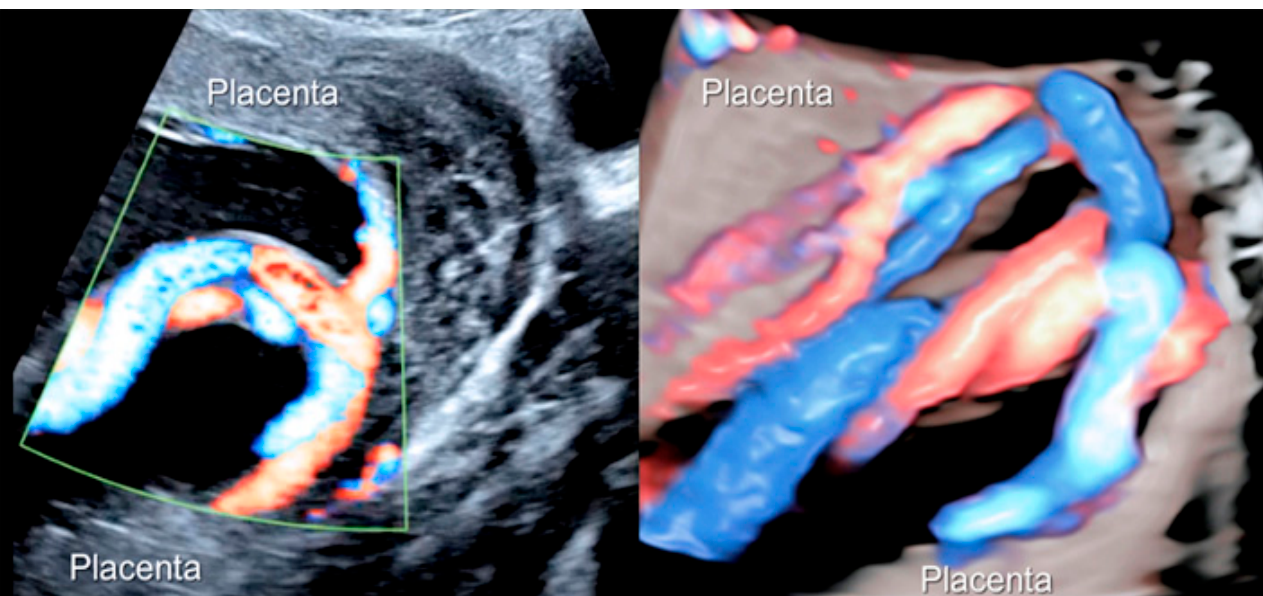
Figure 5. Two-dimensional color Doppler ultrasound and three-dimensional ultrasound using HD- Live™ flow showing a bilobed placenta. When an accessory lobe is detected (succenturiate) in the lower part of the uterus, careful evaluation with ultrasound for vasa praevia and velamentous cord insertion should be performed.